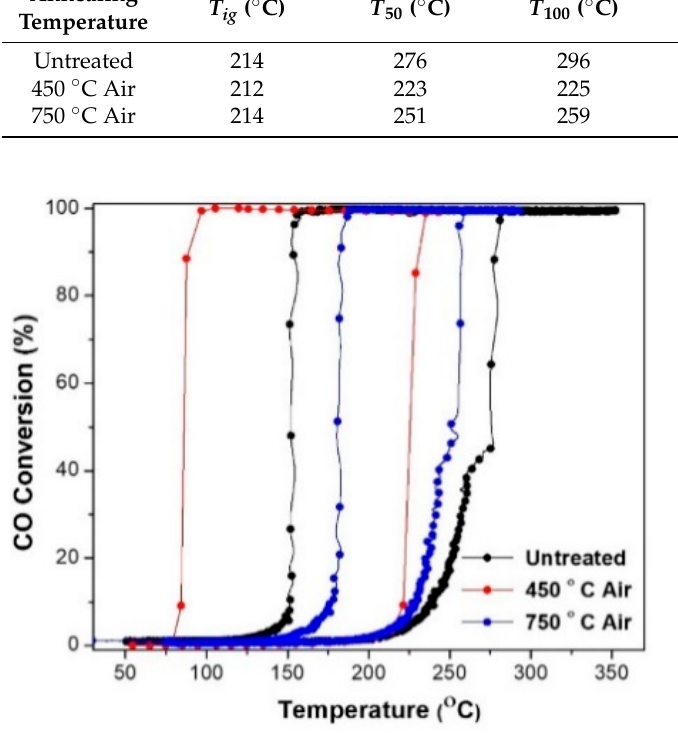
Figure 6. Comparison between the catalytic activity curves of Pd/SiO 2 aerogel catalysts annealed for 1 h in air at different temperatures during ignition and extinction cycles.